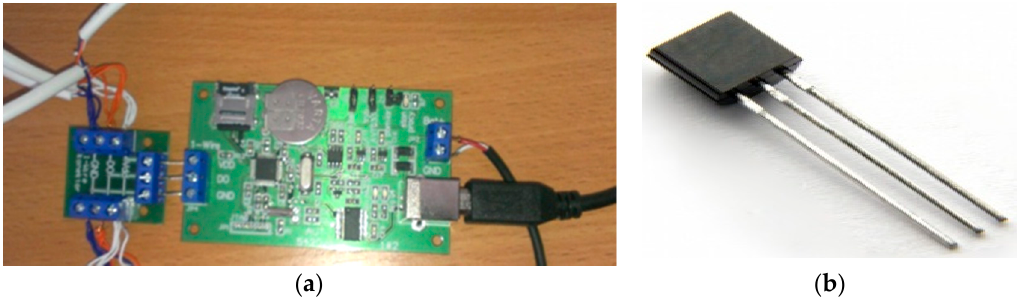
Figure 2. Measurement complex: ( a ) AVT5330 recorder; ( b ) DS18B20 sensor.